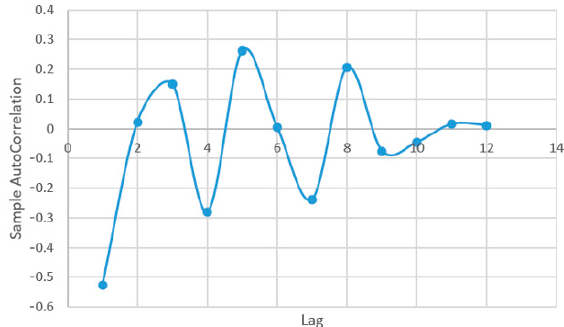
Figure A2. The PAC with transformation in square roots—Series A.